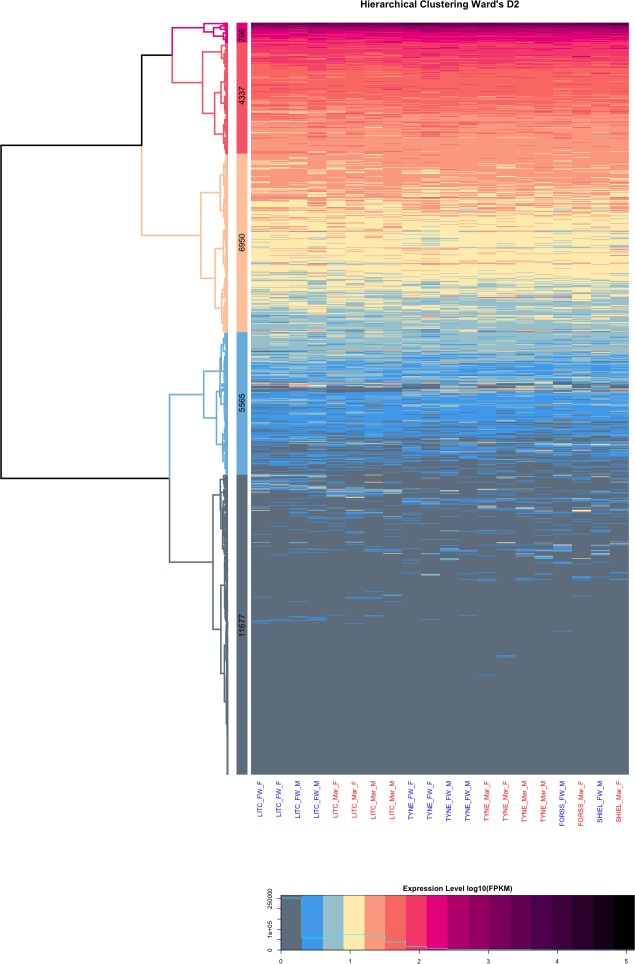
Hierarchical clustering of stickleback gill transcriptome by expression level in 20 marine and freshwater fish reared under standard laboratory conditions reveals five major groups of loci based on their average expression level.The most highly expressed group of genes showing strong enrichment for biological processes with the respiratory function of the gill including mitochondrial respiration, ATP synthesis coupled proton transport and cytoplasmic translation (Appendix 1).